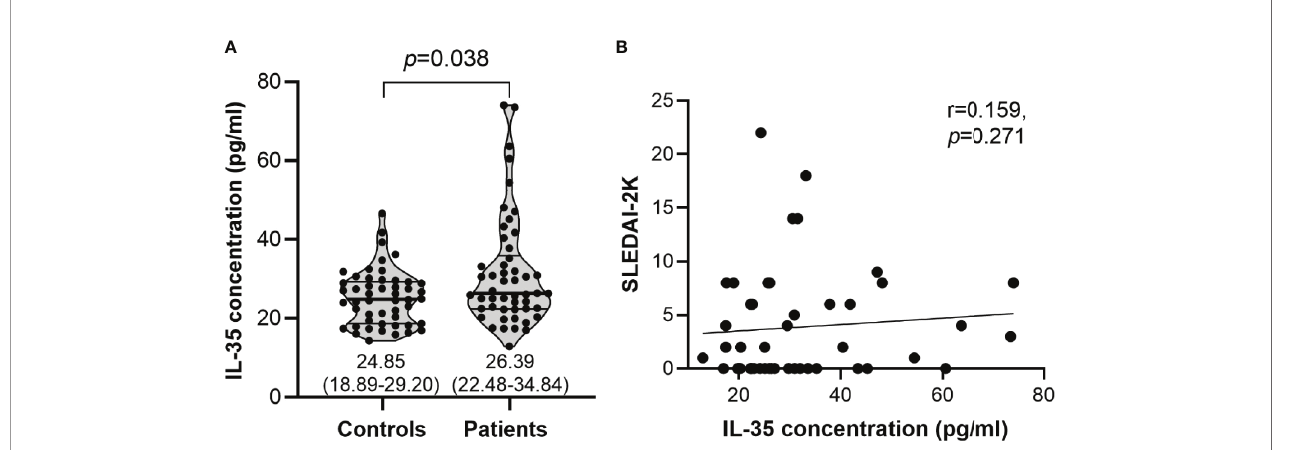
FIGURE 2 | Serum IL-35 levels and their association with SLEDAI-2K scores. (A) Serum IL-35 levels (pg/ml) in healthy controls (n=50) vs SLE patients (n=50). The inset numbers below each violin plot represent median (IQR). (B) Association of serum IL-35 levels with SLEDAI-2K scores in SLE patients